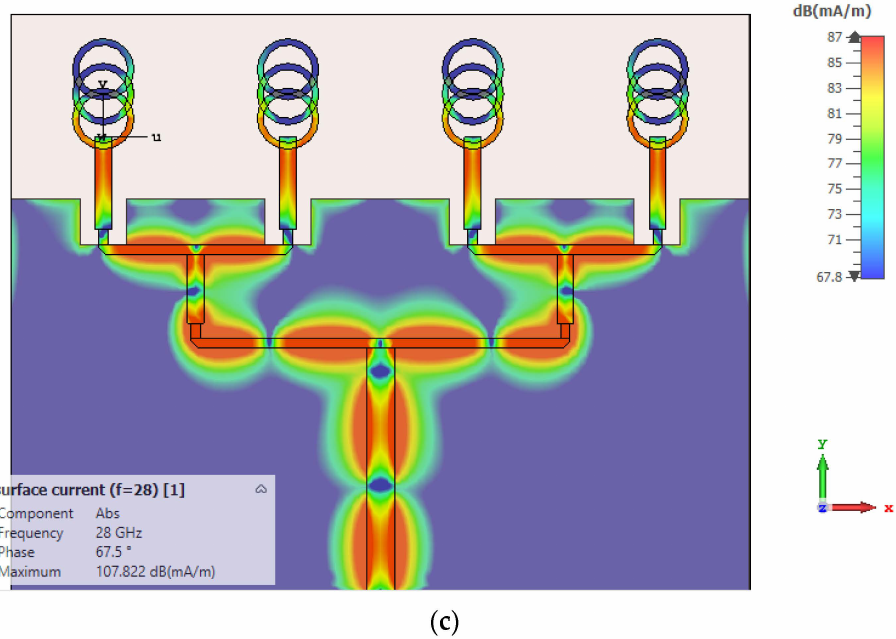
Figure 5. ( a ) Front layer, ( b ) back layer, and ( c ) surface current distributions of the proposed four- element antenna.